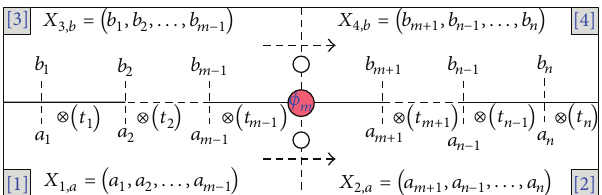
Figure 3: Four divided